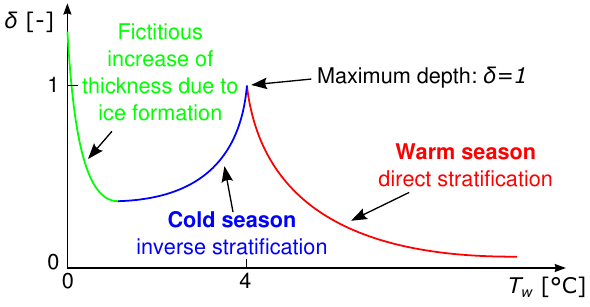
Fig. 2. Seasonal evolution of the dimensionless thickness δ of the surface well-mixed layer for the general case of a dimictic lake.